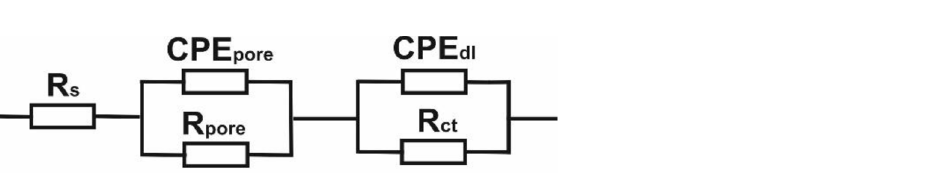
Figure 14. Electrical equivalent circuit of the corrosion system for samples made of Mg–Zn–Ca–Au Figure 13. Impedance spectra obtained for Mg–Zn–Ca–Au sintered alloy. ( a ) Nyquist diagram, ( b ) sintered alloy. Bode’s diagram. The symbols in ( b ) refer to the amplitude (circles) and phase spectra (“plus” sign)